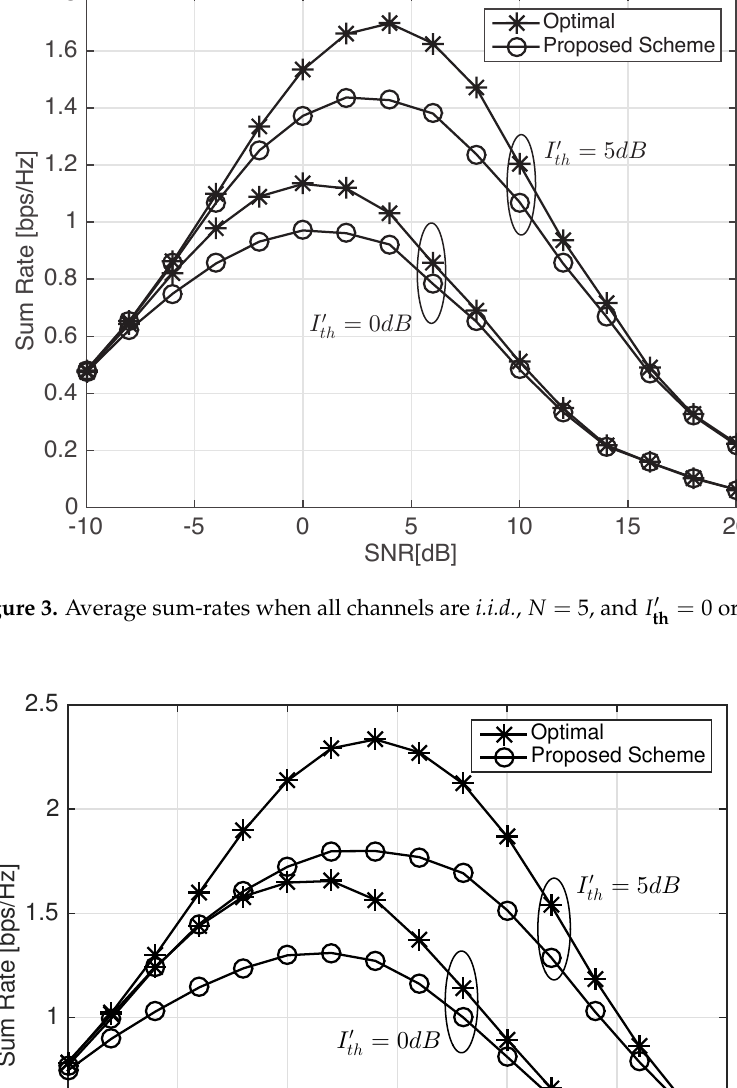
Figure 4. Average sum-rates when all channels are i.i.d. , N = 10, and I (cid:48)